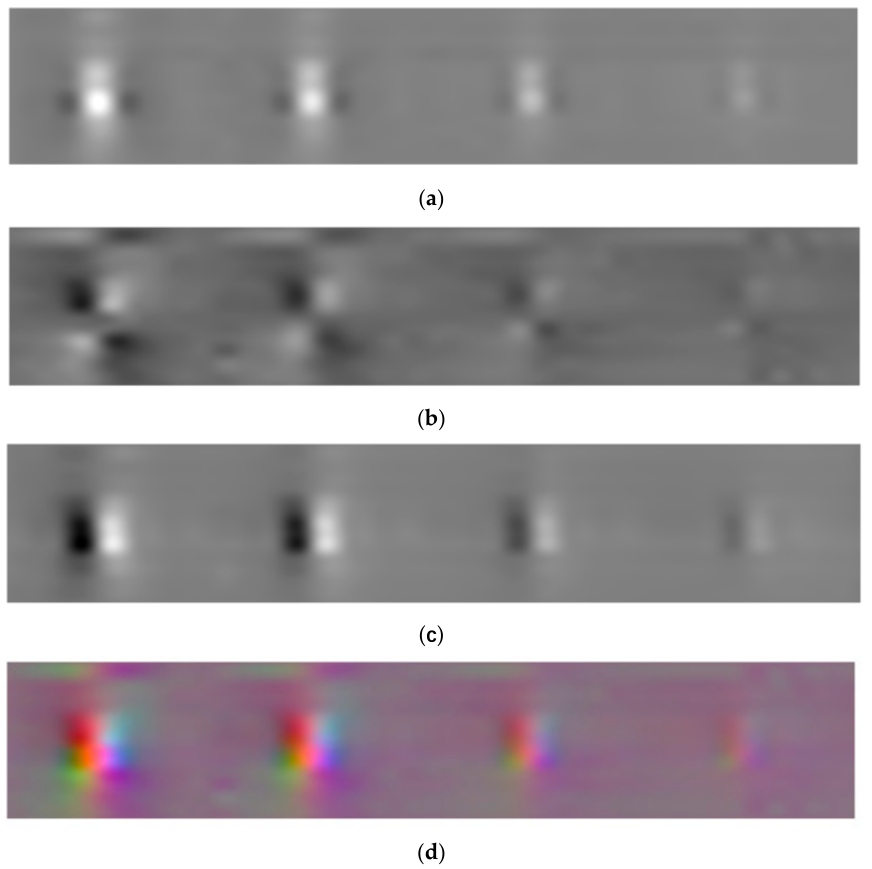
Figure 9. ( a ) gray image of the X-axis; ( b ) gray image of the Y-axis; ( c ) gray image of the Z-axis; ( d ) color image of the three axes.